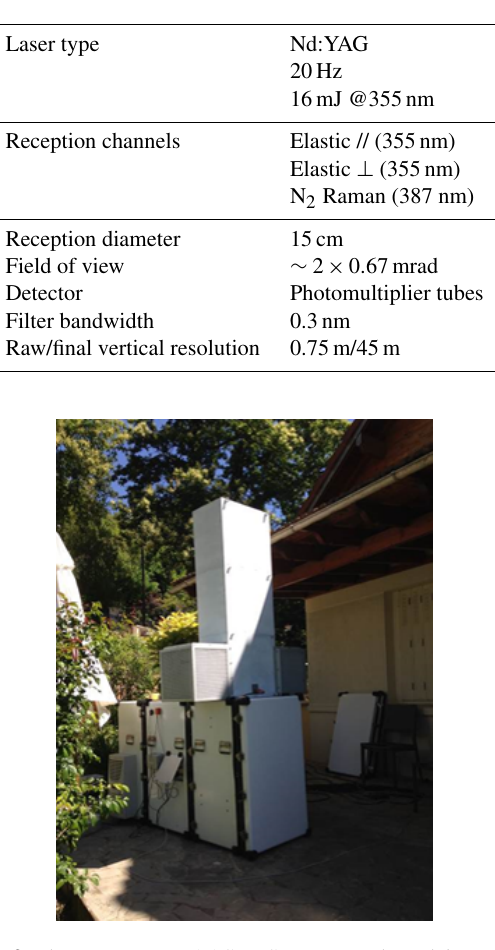
Figure 2. The N 2 Raman LAASURS system at the Palaiseau